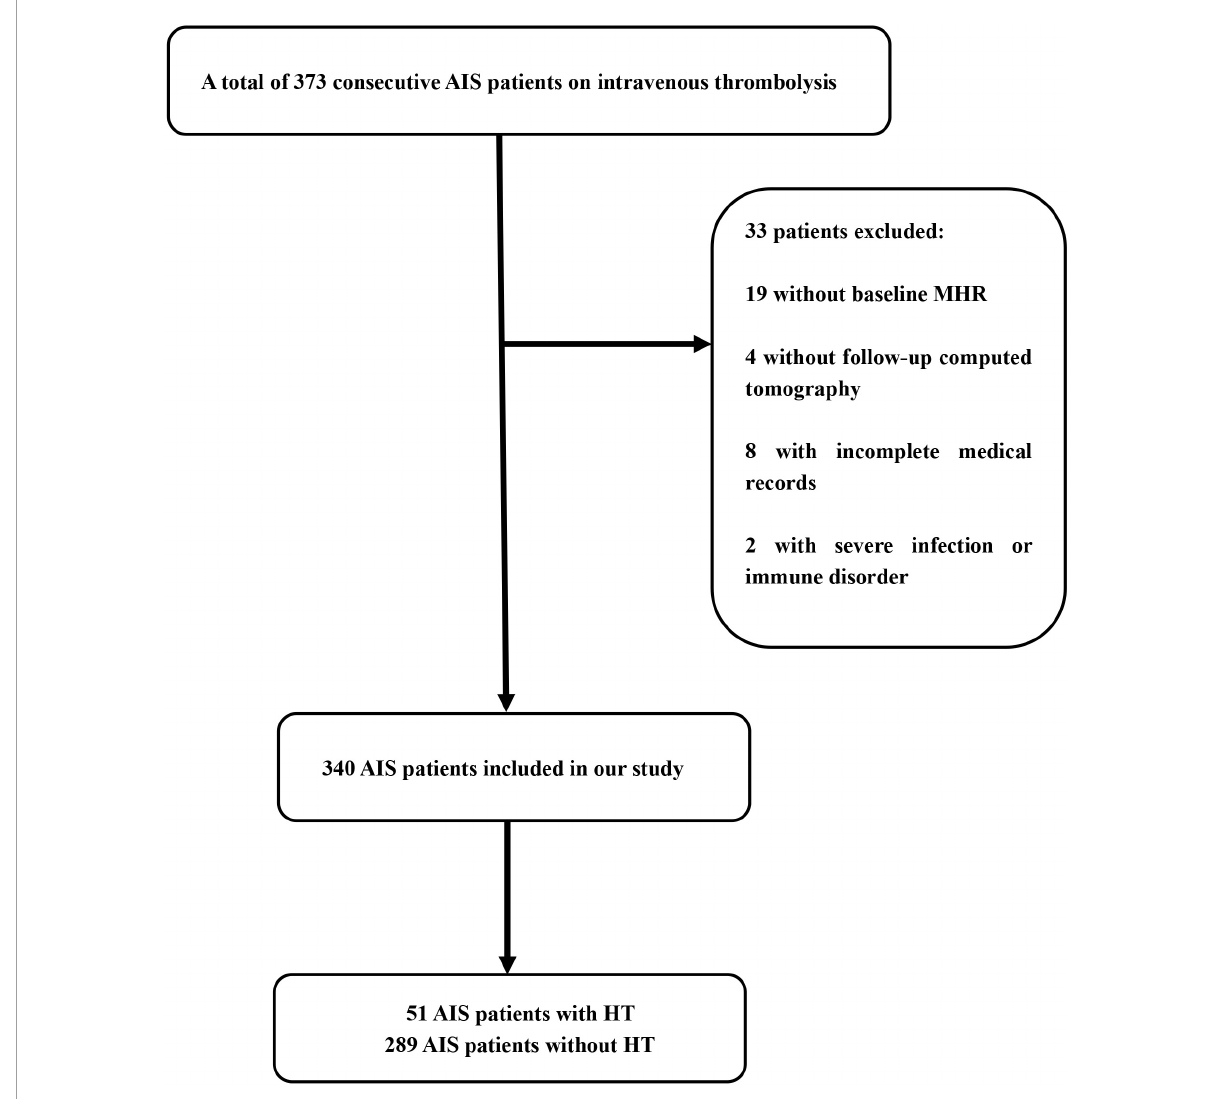
FIGURE1 Flow diagram of patient enrollment. AIS, acute ischemic stroke; HT, hemorrhagic transformation; MHR, monocyte to high-density lipoprotein